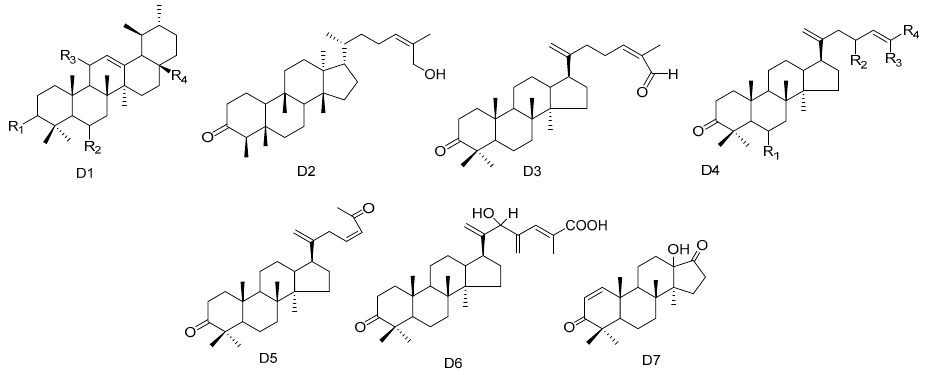
Figure 4. Seven types (D1–D7) of other triterpenes skeletons.